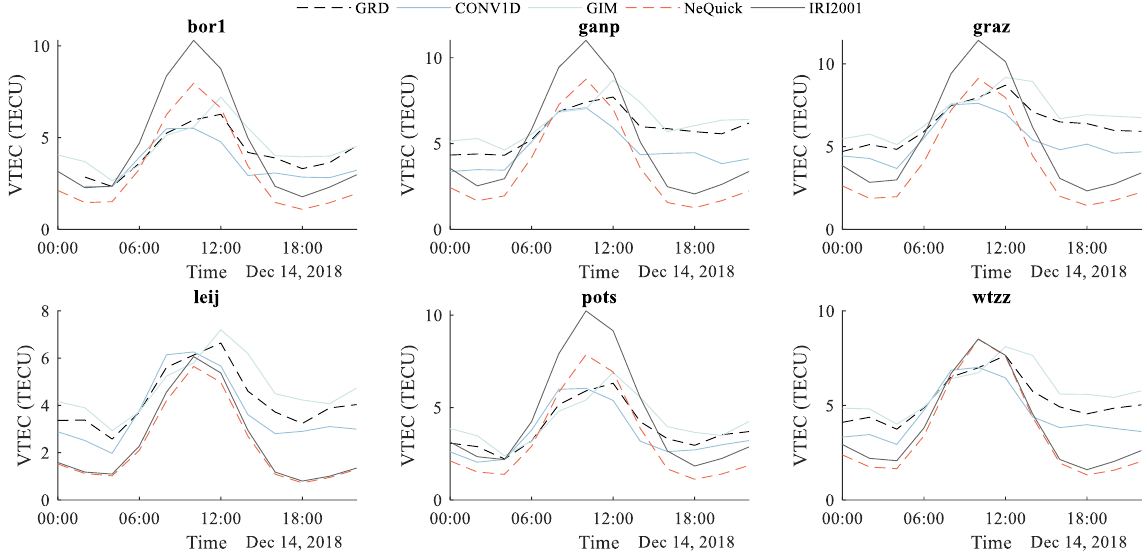
Figure 4. Conv1d versus ground truth per satellite